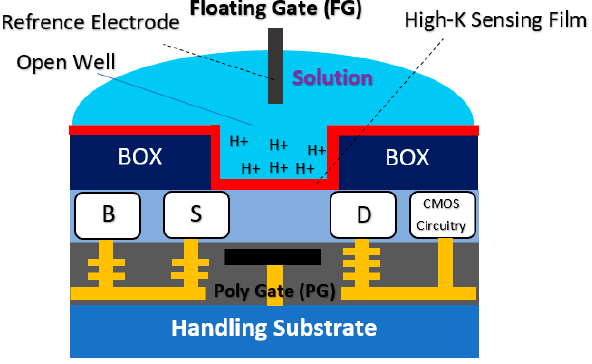
Figure 12. Dual-gate ISFET sensor structure developed in a standard 0.18 µm SOI-CMOS process and through a backside process the back gate has been developed to make a double-gate structure. The sensor completely is working based on the CMOS readout.